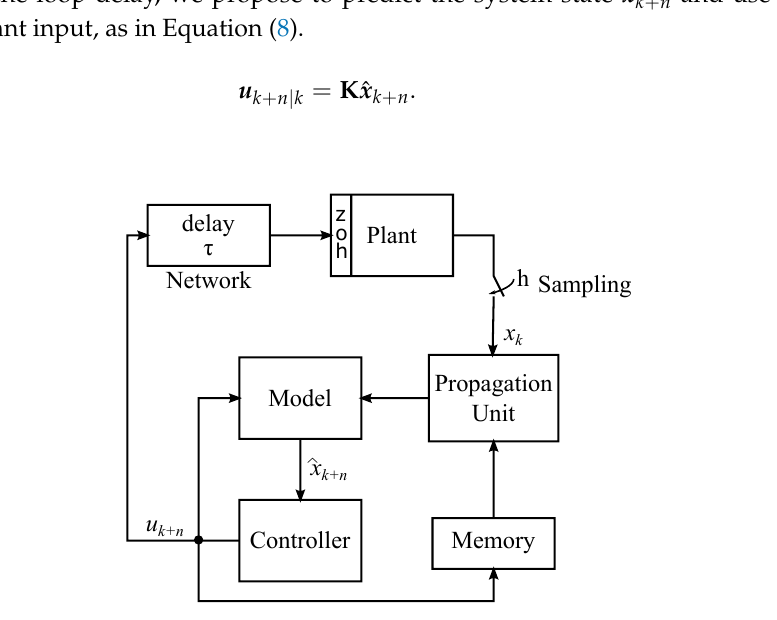
Figure 6. Configuration of the proposed control with long network